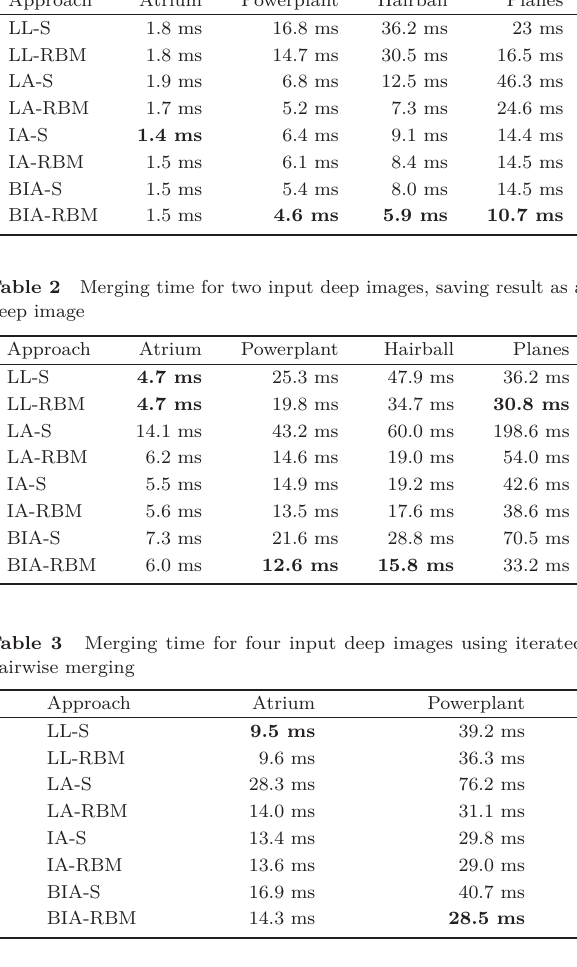
Table 1 Merging time for two input deep images, compositing during merging Approach